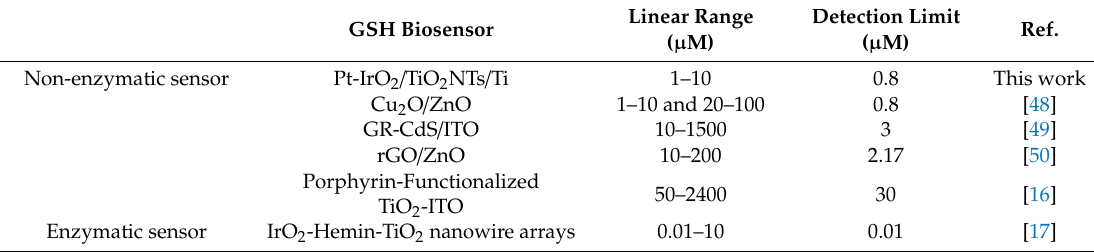
Table 1. Comparison of various GSH